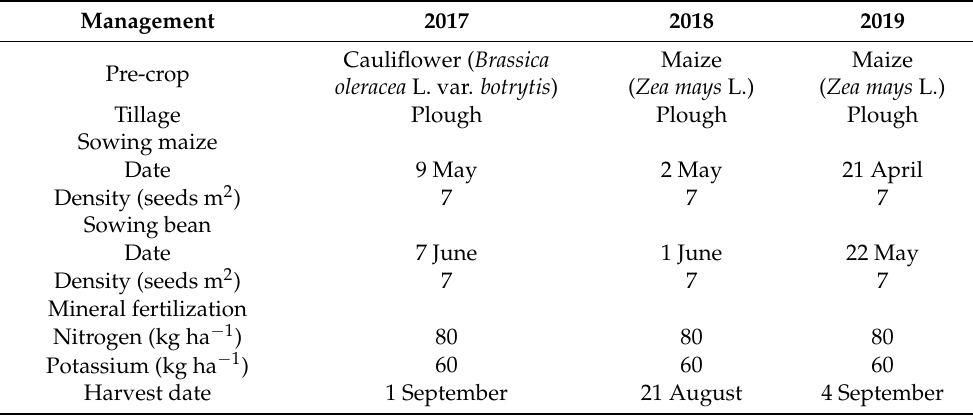
Table 1. Management data of intercropped maize and bean for each experimental year. Pre-crop, type of tillage, sowing dates and densities of maize and bean, mineral fertilization, and harvest